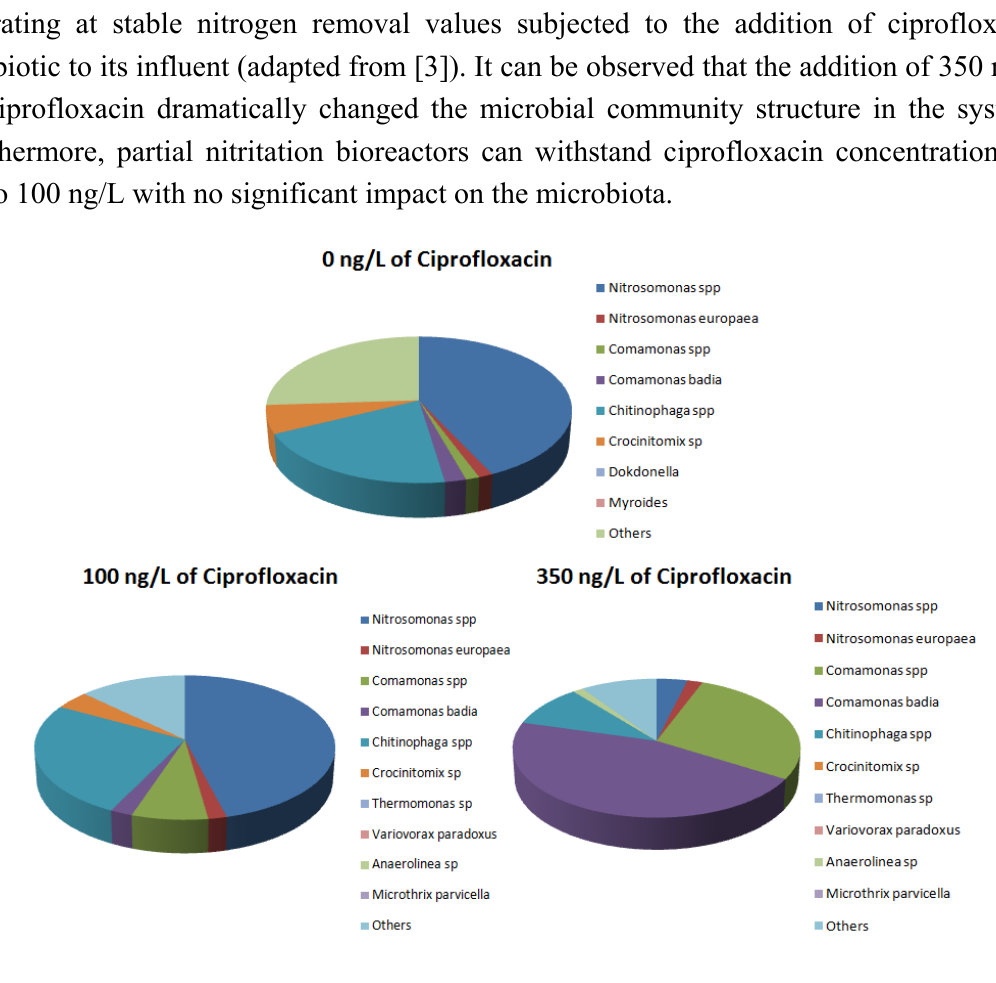
Figure 3. Bacterial community structure of a biofilter partial nitritation